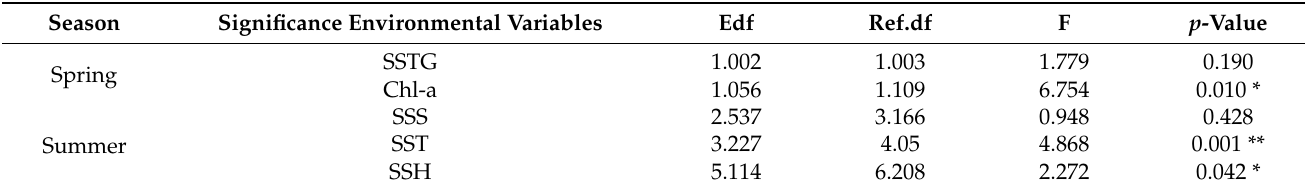
Table 4. Significance test results of explanatory variables.